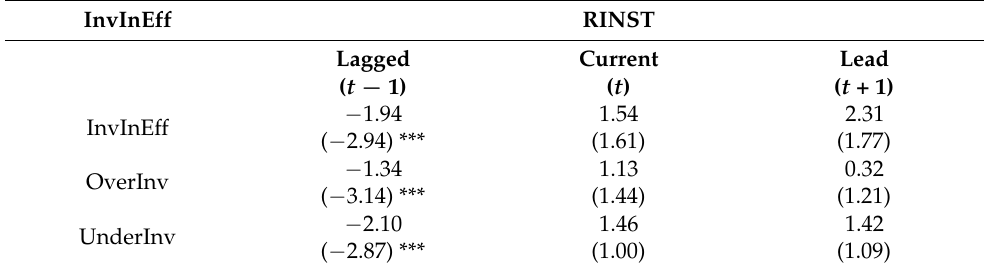
Table 7. Causality tests of institutional ownership.